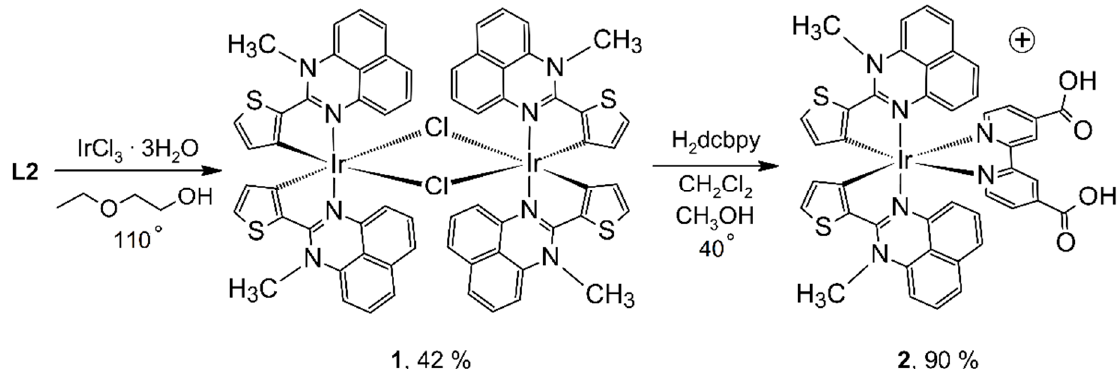
Scheme 2. Preparation of cyclometalated iridium(III) complexes with